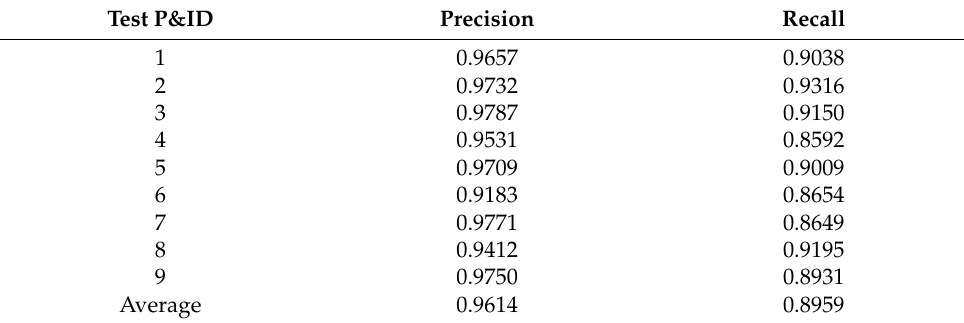
Table 2. Performance evaluation result for test P&IDs.